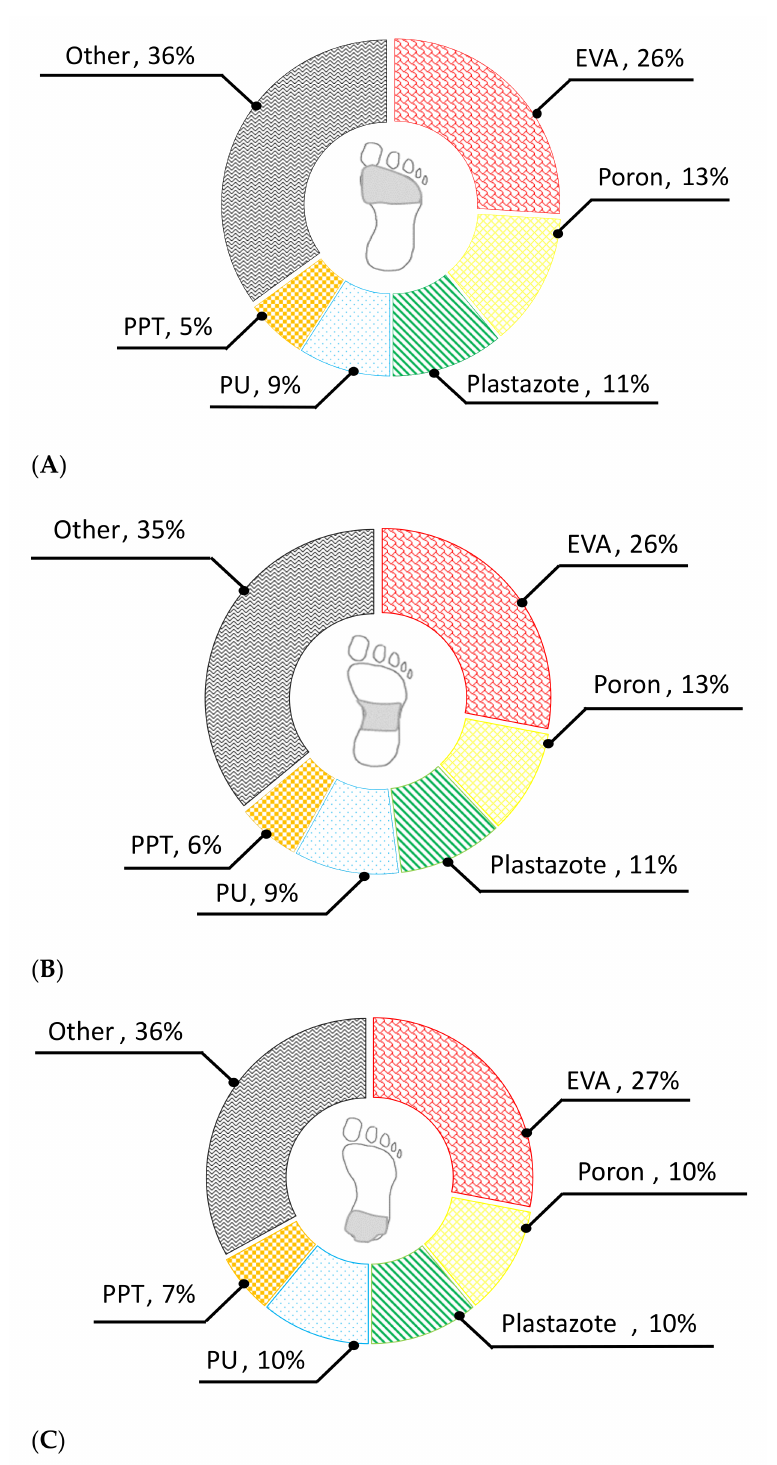
Figure 4. Published paper used insole material under plantar area: ( A ) forefoot, ( B ) midfoot, and ( C ) rearfoot. EVA, ethylene–vinyl acetate; PU, polyurethane; PPT, Professional Protective Technology. The percentage of insole used in the foot region is based on “summary” divided by the total insole used. The term “other” summarizes 11–13 items that do not represent the most used insole